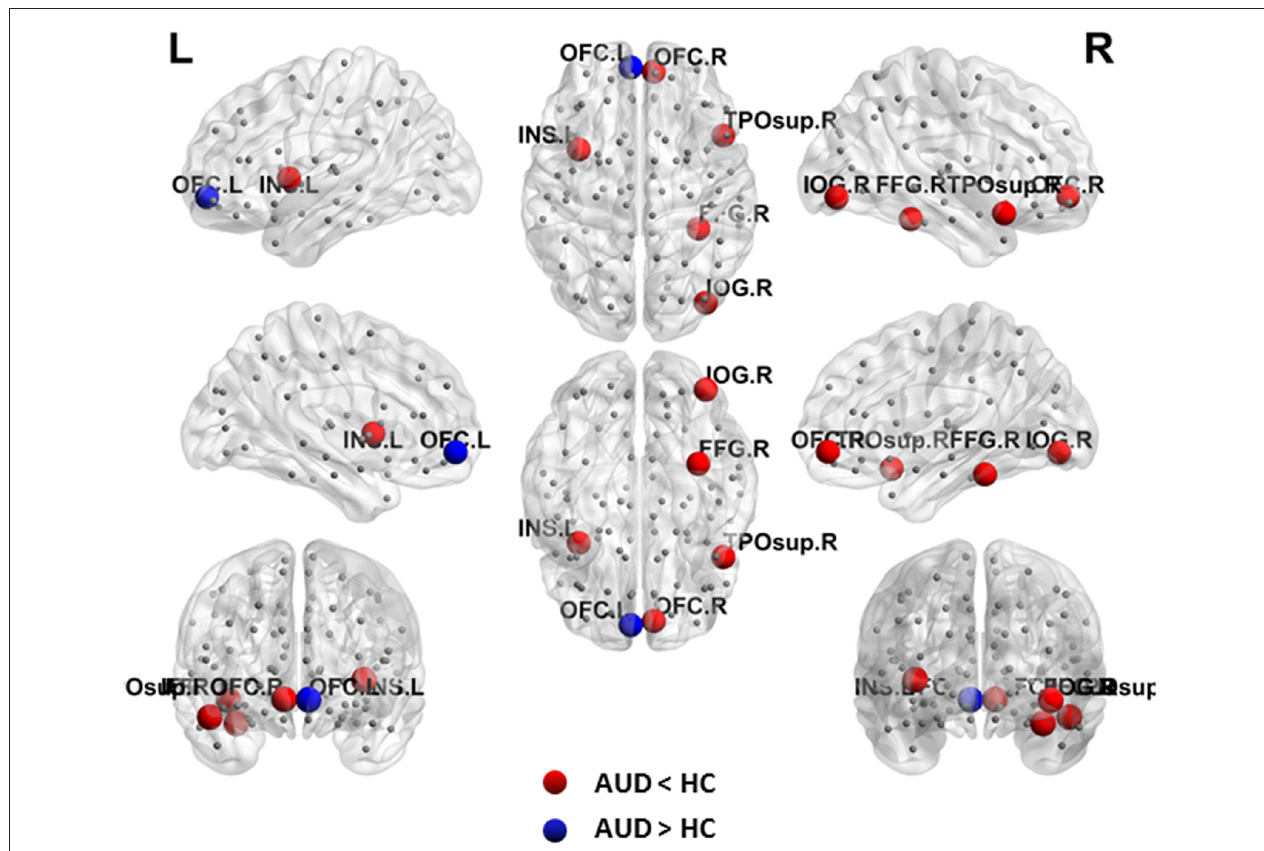
FIGURE 2 | Abnormal nodal efficiency in brain functional networks in the AUD group. Blue dots indicate increased nodal efficiency and red dots indicate decreased nodal efficiency in the AUD group compared with the HC group. AUD, alcohol use disorder; HCs, healthy controls; L, left; R, right; OFC, orbitofrontal cortex; INS, insula; IOG, inferior occipital gyrus; FFG, fusiform gyrus; TPOsup, temporal pole: superior temporal gyrus.